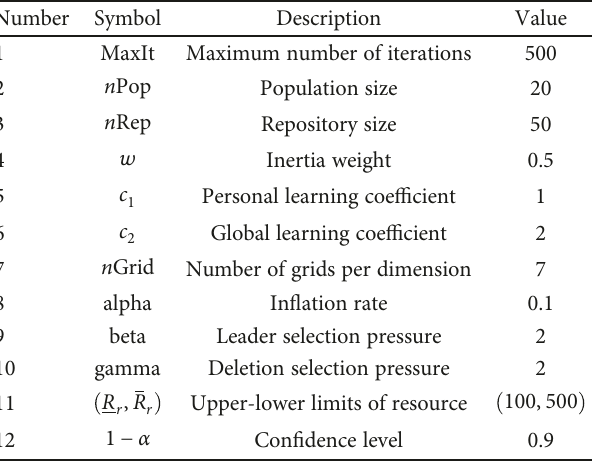
Table 2: Parameter setting of